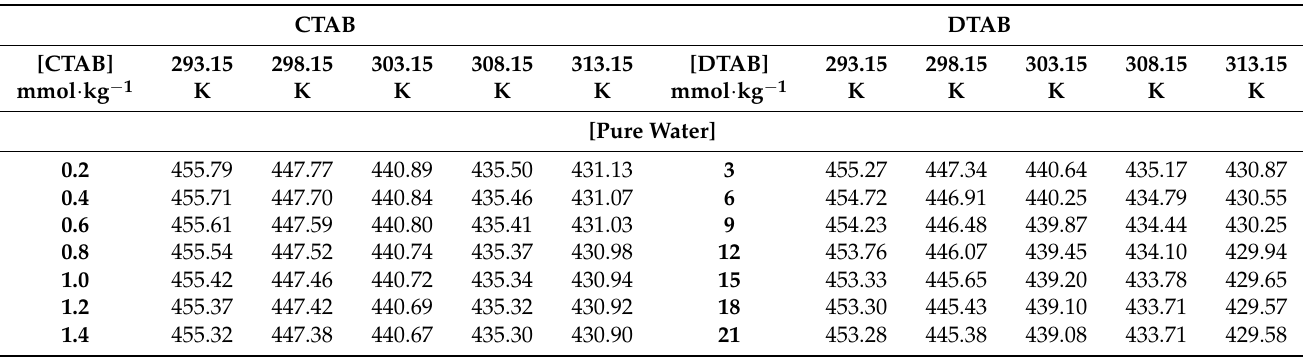
Table 2. Isentropic compressibility, κ s (TPa − 1 ) values for CTAB and DTAB in pure water and in